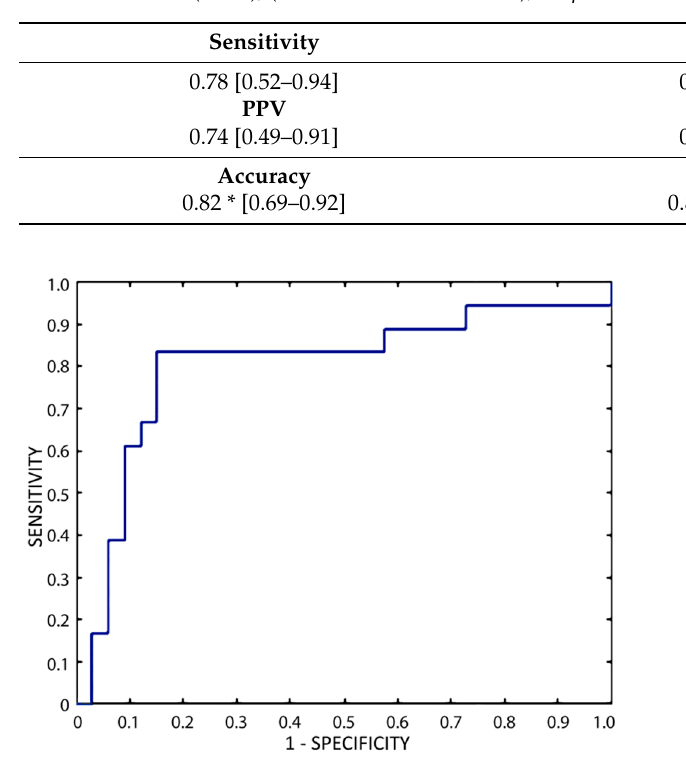
Table 4. Performances obtained in testing the best ensemble of machine learning radiomic classifiers for benign calcifications versus malignant calcification. Performances are reported as sensitivity, specificity, positive predictive value (PPV), negative predictive value (NPV), accuracy, and Area Under the Curve (AUC), (95% Confidence Interval), * = p -value < 0.05, ** = p -value > 0.005.